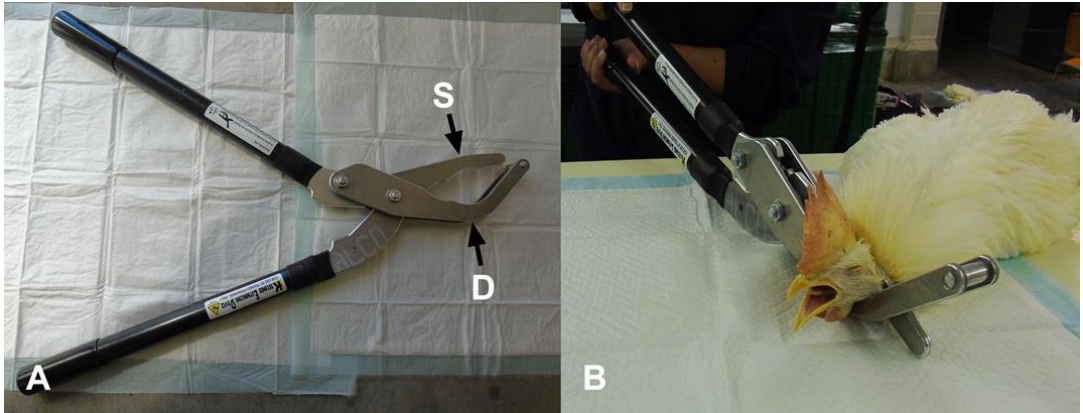
Figure 1. ( A ) Koechner euthanasia device (KED model-C): S — single side blade; D — double angle blade. ( B ) Application of KED model-C in a 65-week-old anesthetized rooster.